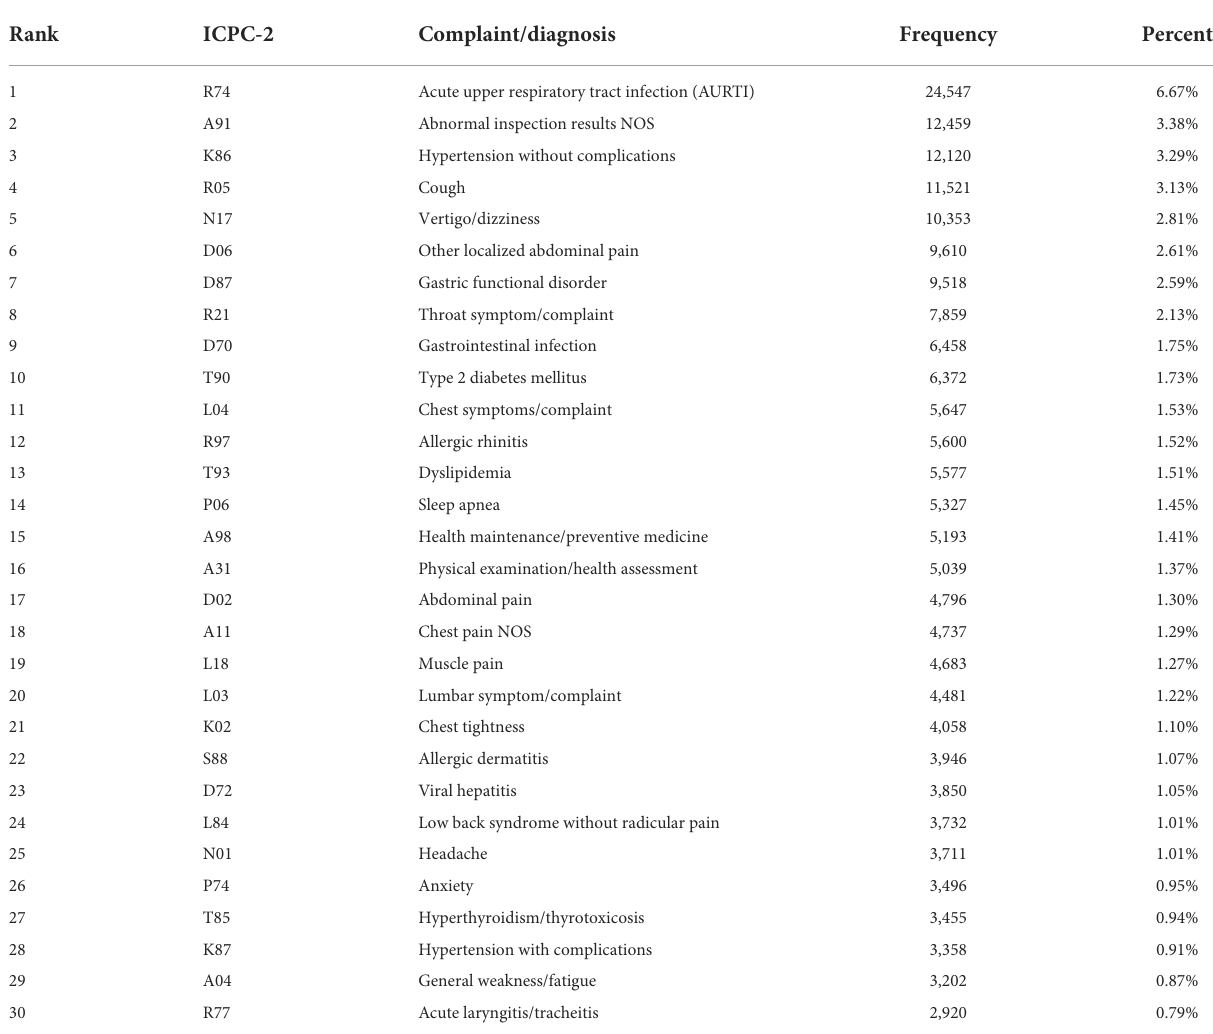
TABLE 3 Top 30 health